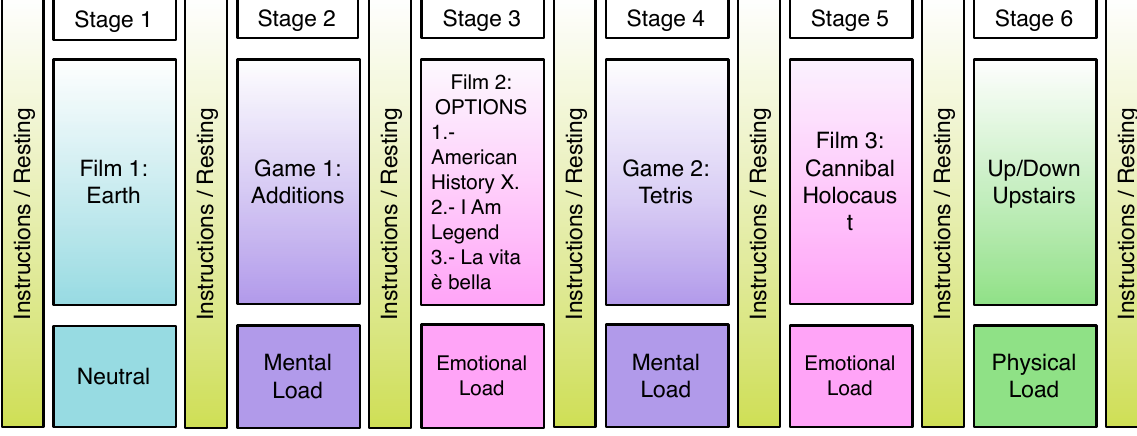
Figure 9. Scheme describing the stages of the experiment used to generate the database.